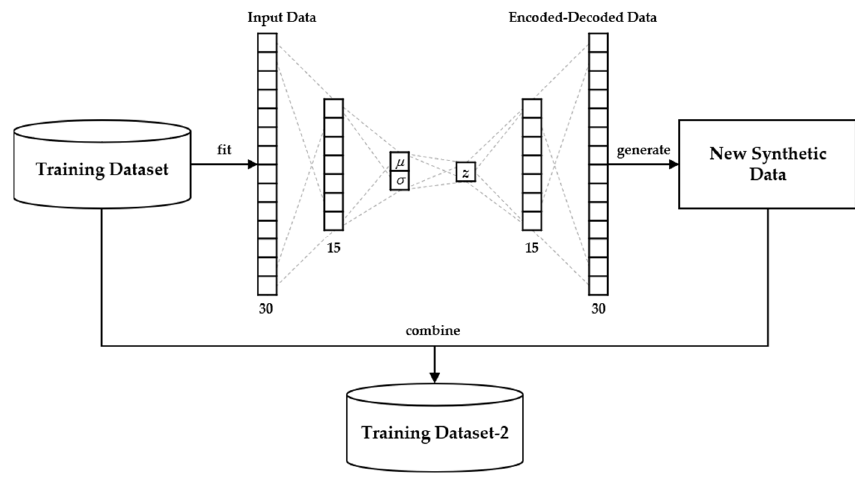
Figure 3. Architecture of the VAE model.